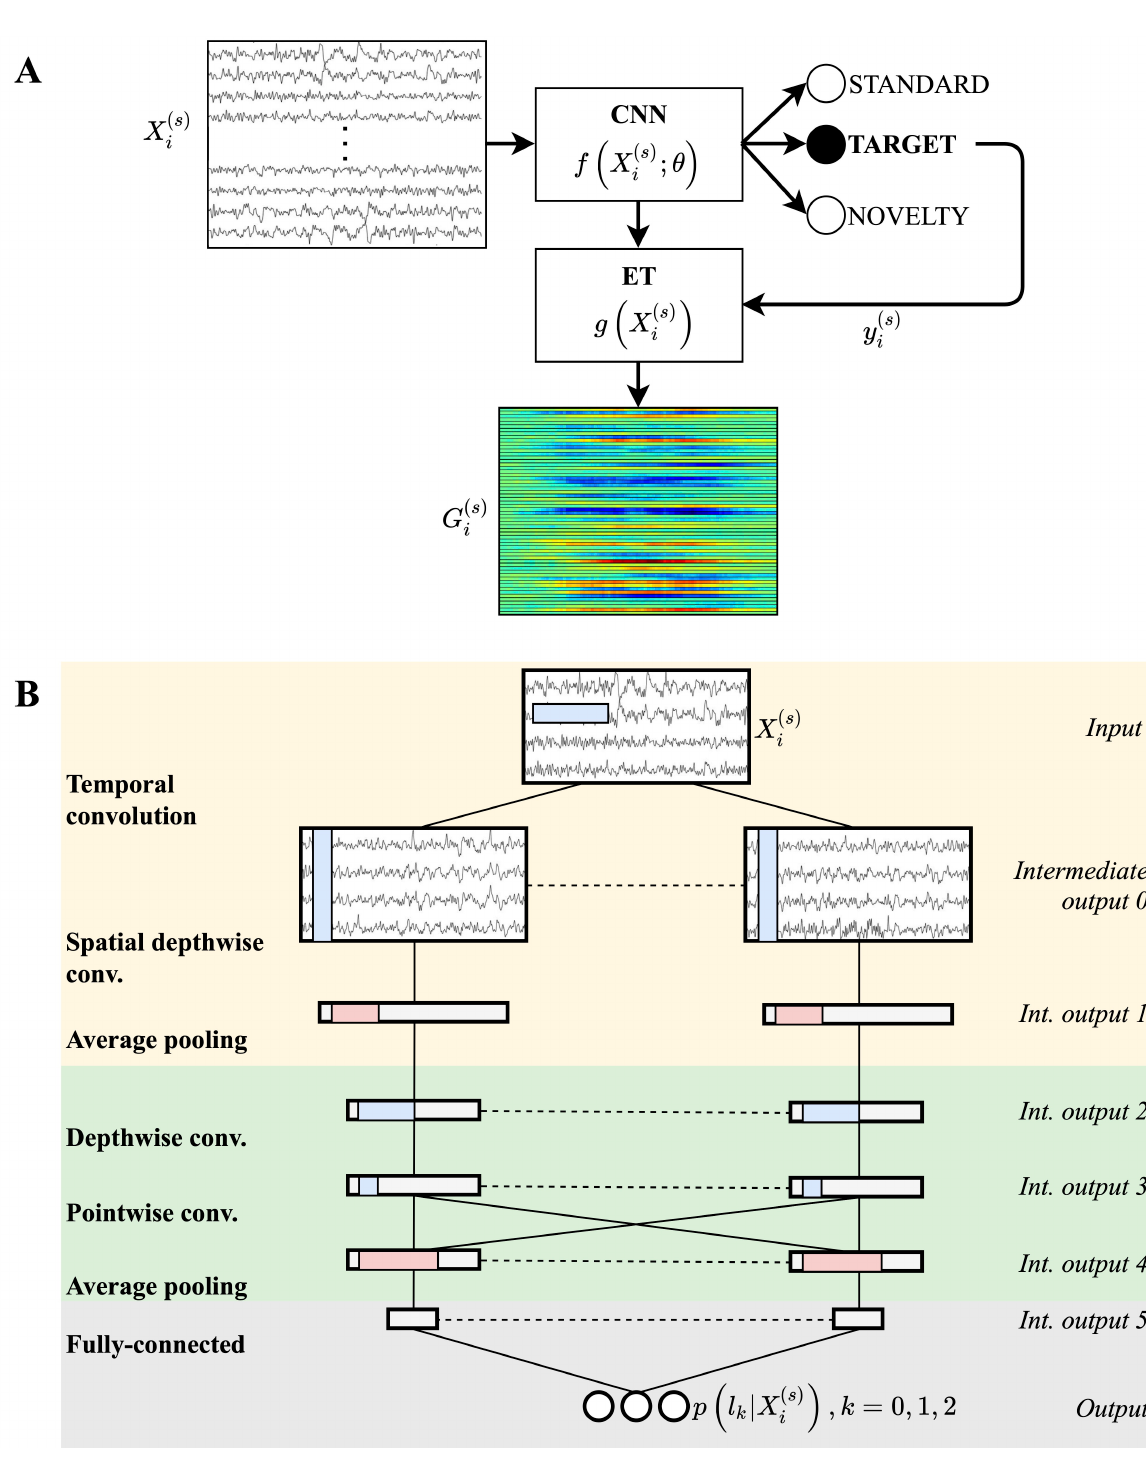
Fig. 1. Proposed data-driven EEG analysis tool: workflow and scheme of the adopted CNN. (A) CNN+ET analysis framework. The input EEG trial ( ) ( ) X i ( s ) isprocessedbytheCNN-basedparametricclassifier f X i ( s ) ; θ X i ( s ) ; θ . Using f andthecorrectoutputlabel y i ( s ) ,therelevancerepresentation ( ) g X i ( s ) is computed. (B) Schematic representation of EEGNet, implementing the parametric classifier f . Only its main layers are represented, for a more detailed description see Section 2.3.1 and Supplementary Table 1 ; in particular note that non-linear activation layers have been omitted in this figure, but they are present in the implementation. The input X i ( s ) is processed by the CNN through many layers (with the layer name reported on the left) organized in 3 main blocks (spatio-temporal block: yellow, temporal block: green, fully-connected block: grey) to obtain the output conditional probabilities ( ) p l k | X i ( s ) , k = 0 , 1 , 2 . The intermediate output of each layer is reported as a white box with the spatial and temporal dimensions along rows and columns, respectively. Coloured boxes represent the filters of convolutional (blue boxes) and pooling (red boxes) layers.